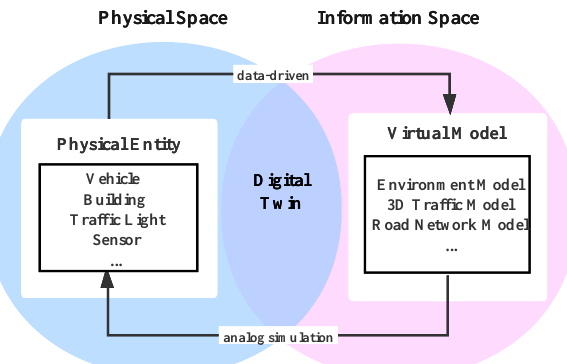
Figure 1. Physical information linkage of a digital twin system. The physical space with physical entities provides data for the information space, and the information space with virtual models simulates the information provided by the object space. The physical units mainly include vehicles, buildings, traffic lights, sensors, etc. Virtual model mainly refers to environment model (environment and weather modeling based on data provided by sensors), 3D traffic model (3D modeling based on building and traffic light information), road network model (road network modeling based on lane information and road information),